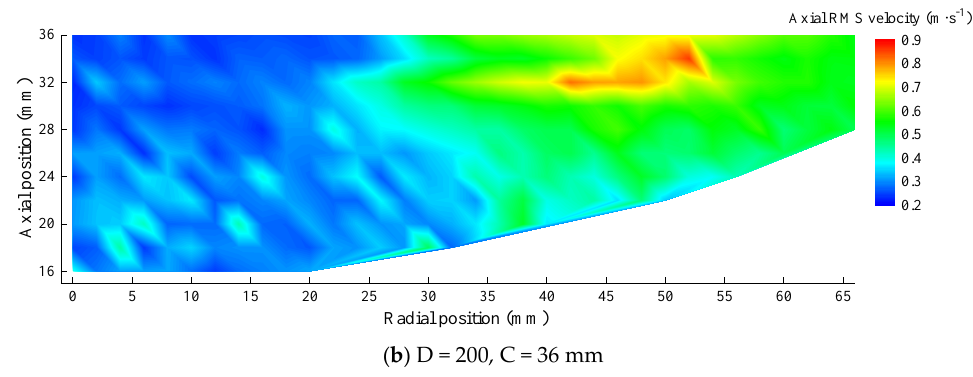
Figure 10. Axial RMS velocity distribution in the centrifugal flow.